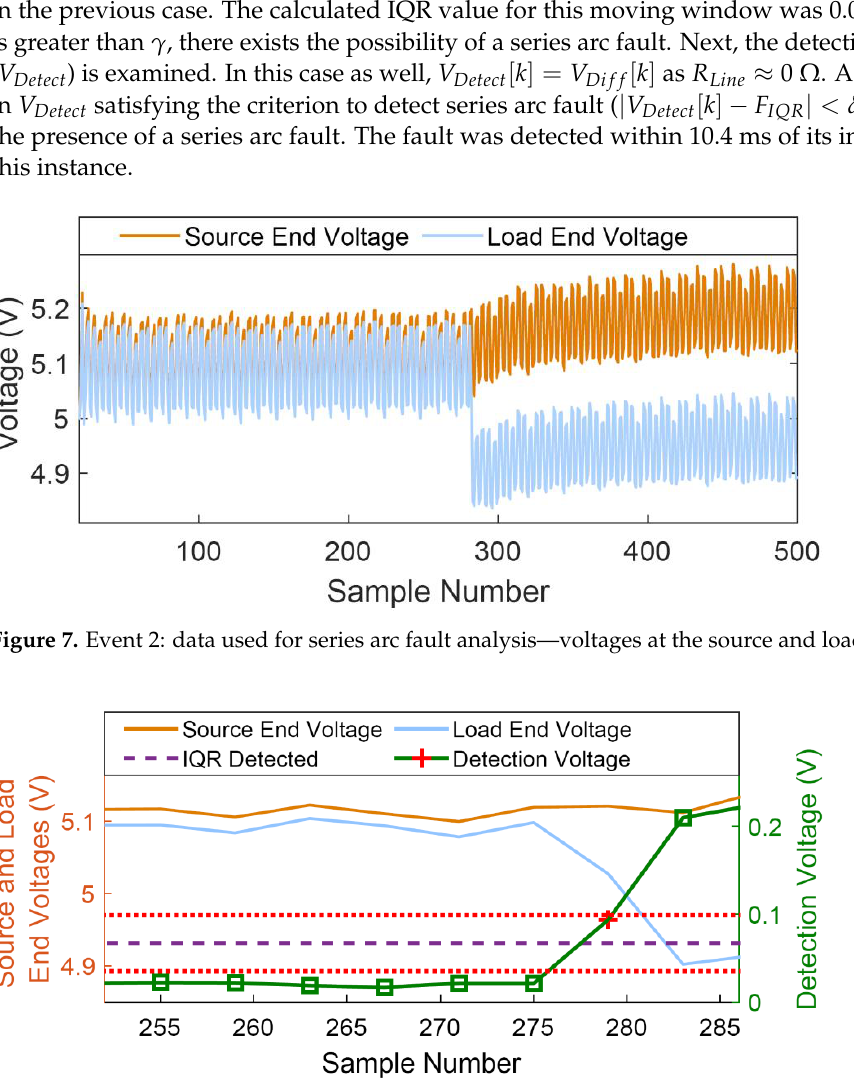
Figure 8. Event 2: detecting a series arc fault using the proposed